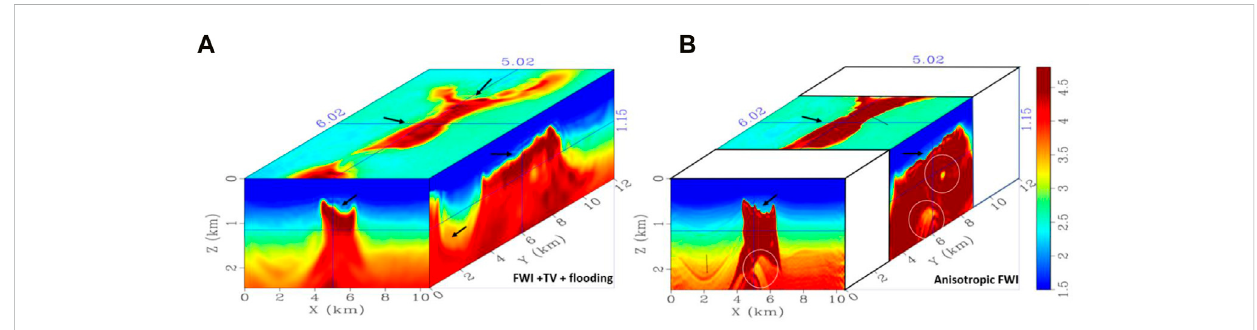
FIGURE 6 (A) Updatedvelocitymodelusing2 Hzofdominantfrequency.Theshapeofthesalt(especiallythetopofthesalt)isrecoveredusingregularizedFWI. (B) Velocity model after salt fl ooding. Compared with the inverted velocity update after TV regularization, most of the salt body has been recovered.